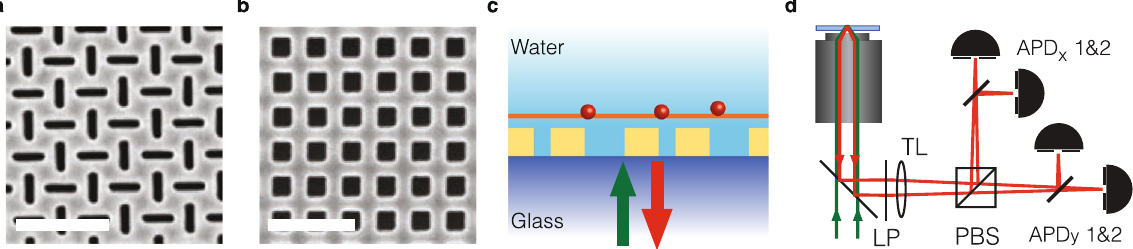
Figure 4. Proof of principle experiment for nano-aperture enhanced fluorescence correlation spectroscopy. ( a,b ) SEM images of a polarization sensitive nano-aperture array of rectangular 165 by 50 nm slits at 180 nm pitch ( a ) and a polarization insensitive reference array of 100 × 100 nm 2 square apertures at 200 nm pitch ( b ). Scalebars indicate 500 nm. ( c ) In the experiment the gold film is covered by a 30 nm SiO 2 coating (spincoated HSQ) which supports a lipid bilayer. Emitters are diffusing in the plane of the lipid bilayer. The sample is immersed in water, and we pump and collect emission from the glass side of the sample. ( d ) We study a lipid bilayer sample in a confocal fluorescence microscope. Light collected from the emitters is passed through a longpass (LP) filter, and split into polarization channels by a polarizing beam splitter (PBS). We use two APDs per polarization channel to avoid artefacts due to APD deadtime and